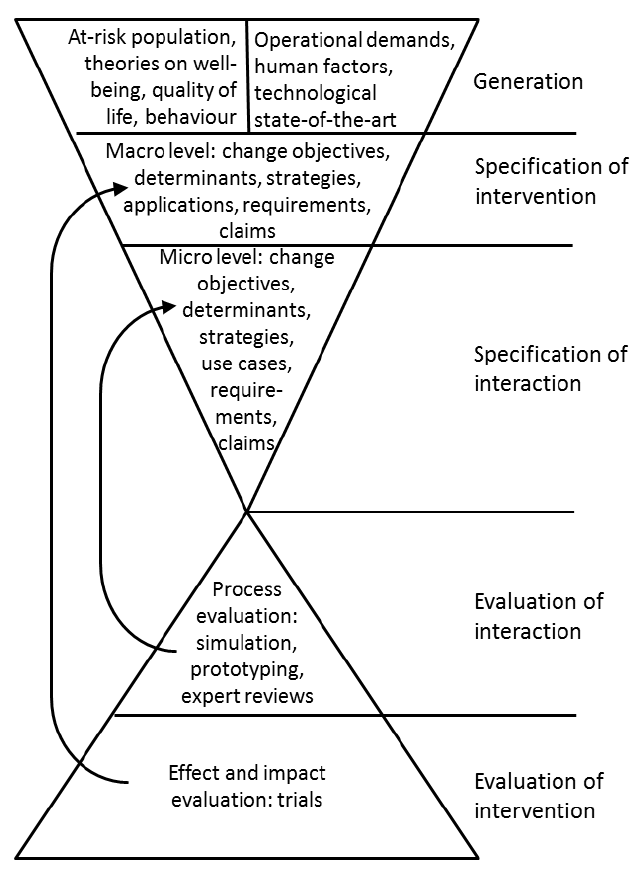
Fig. 1. Components of approach for developing persuasive